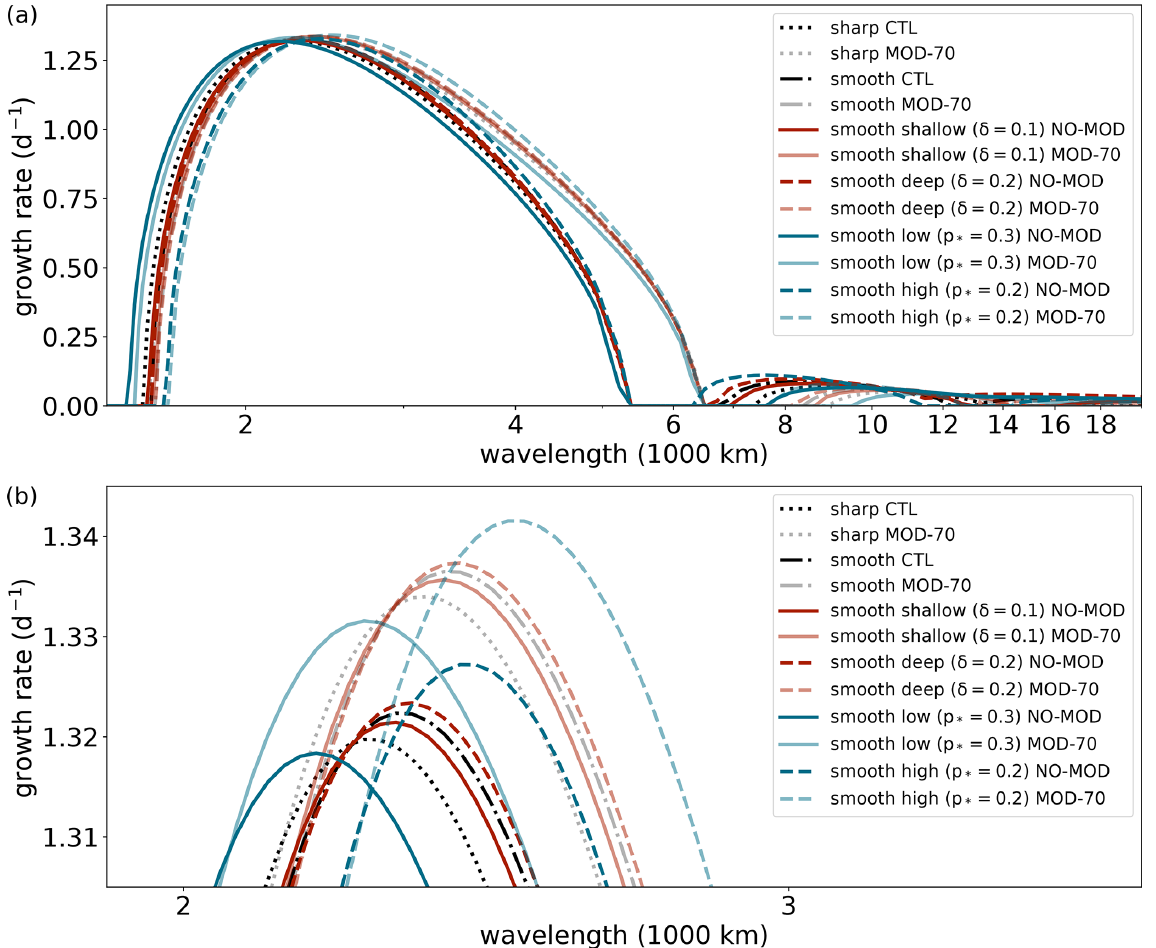
Figure 10. Same as Fig. 6 but including latent heating with ε = 2.